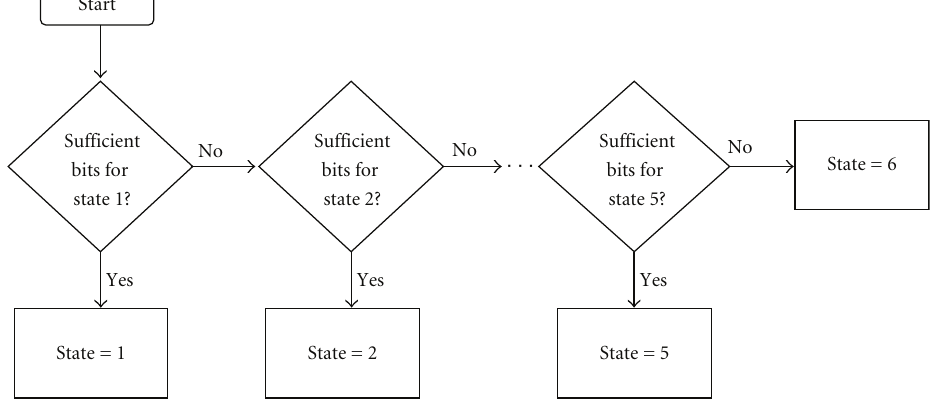
Figure 2: Flow diagram describing encoder state determination.